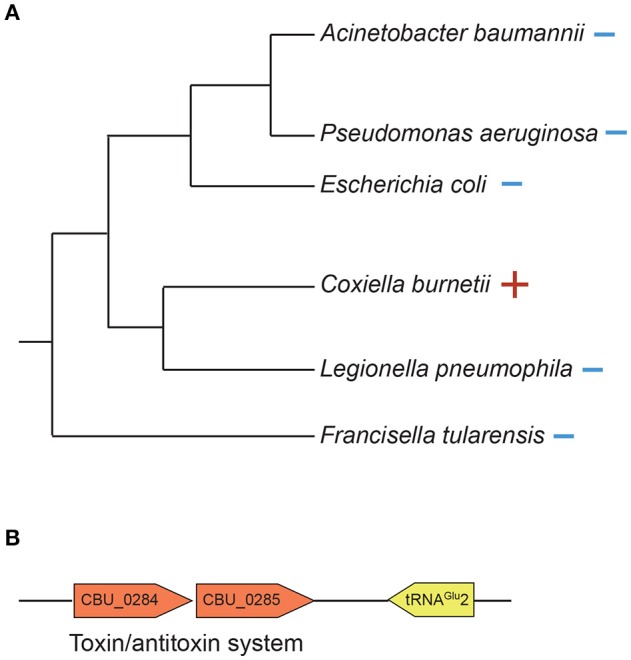
tRNAGlu2 was horizontally acquired by C. burnetii. (A) 16S rDNA phylogenetic tree of Gammaproteobacteria showing the presence (+) or absence (–) of tRNAGlu(anticodon CUC). (B) A putative toxin/antitoxin system is located adjacent to tRNAGlu2.